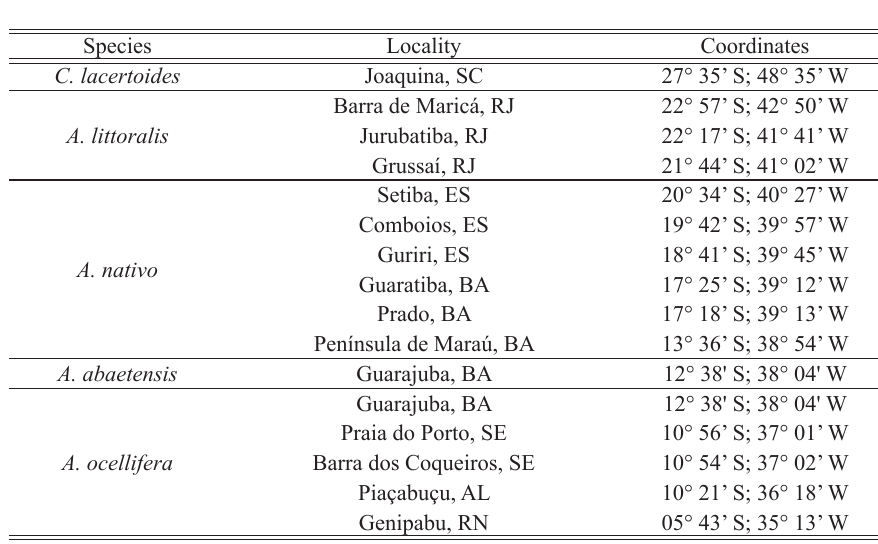
Figure 1 - Distribution of Ameivula and Contomastix species studied in the restingas along the eastern coast of Brazil.